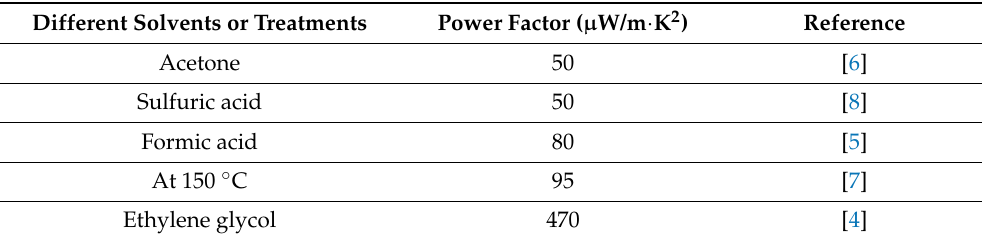
Table 1. Power factor of PEDOT:PSS films obtained by different solvents or treatments, as reported in the